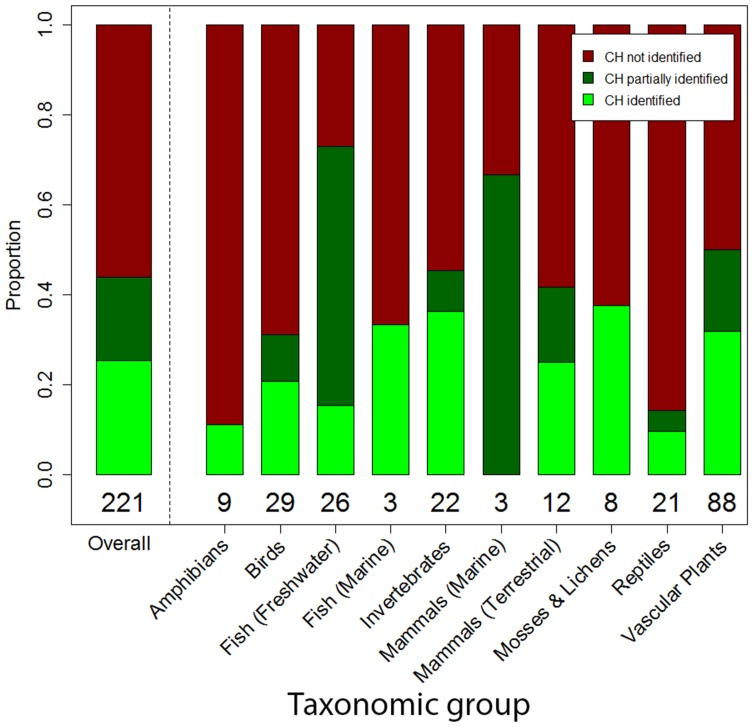
Proportion of SARA-listed species (listed as extirpated, endangered, or threatened) that have critical habitat (CH) fully identified (light green), partially identified (dark green), or not at all identified (dark red), overall and by taxonomic group.Values under bars indicate the number of species in each taxonomic category.